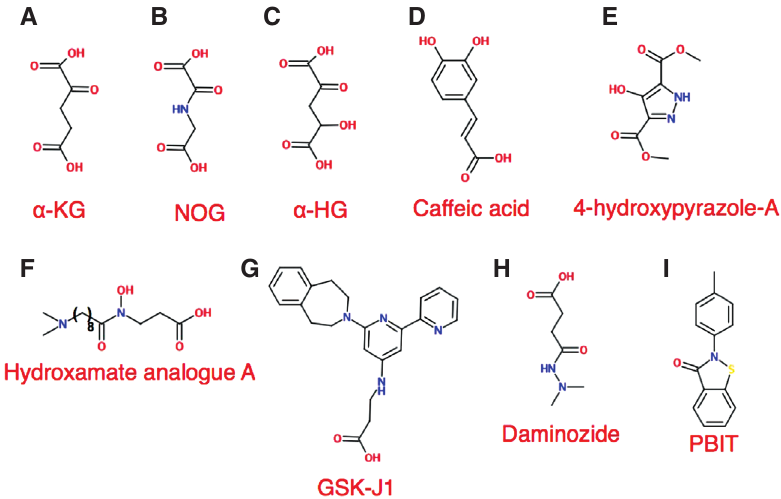
Figure 4 Chemical structure of JmjC